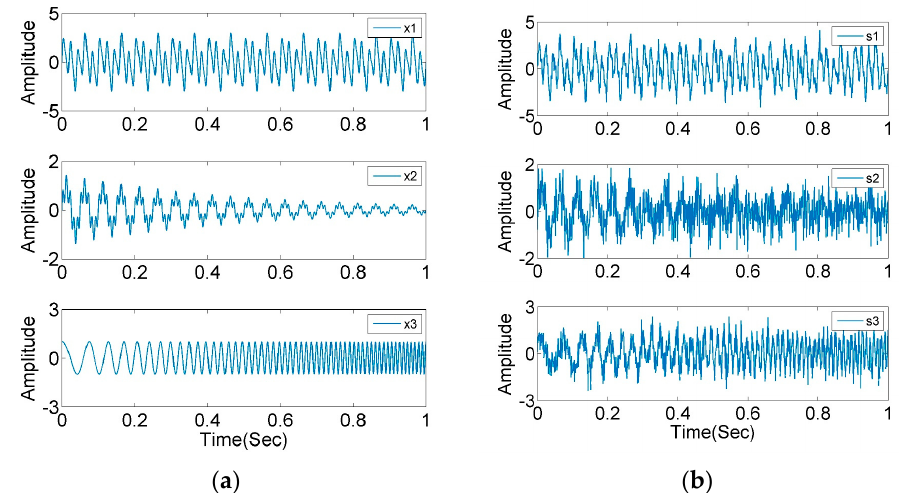
Figure 3. Waveform diagrams of simulation signals: ( a ) clean signals; ( b ) polluted signals with Gaussian white noise of 5 dB.